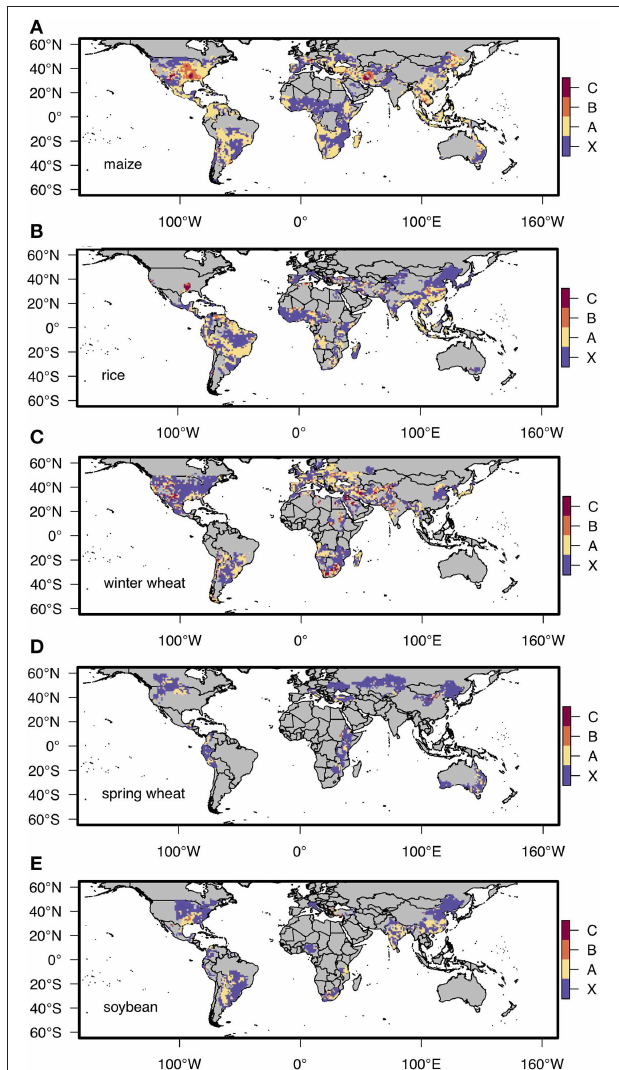
FIGURE 2 | Horizontal distributions of ACC accuracy scores for a 3-months lead prediction of year-to-year variations in yields of (A) maize, (B) rice, (C) winter wheat, (D) spring wheat, and (E) soybean. Gray indicates non-growing areas for the respective crops. ( ± 0.6%) for maize, rice, winter wheat, spring wheat, and soybean,